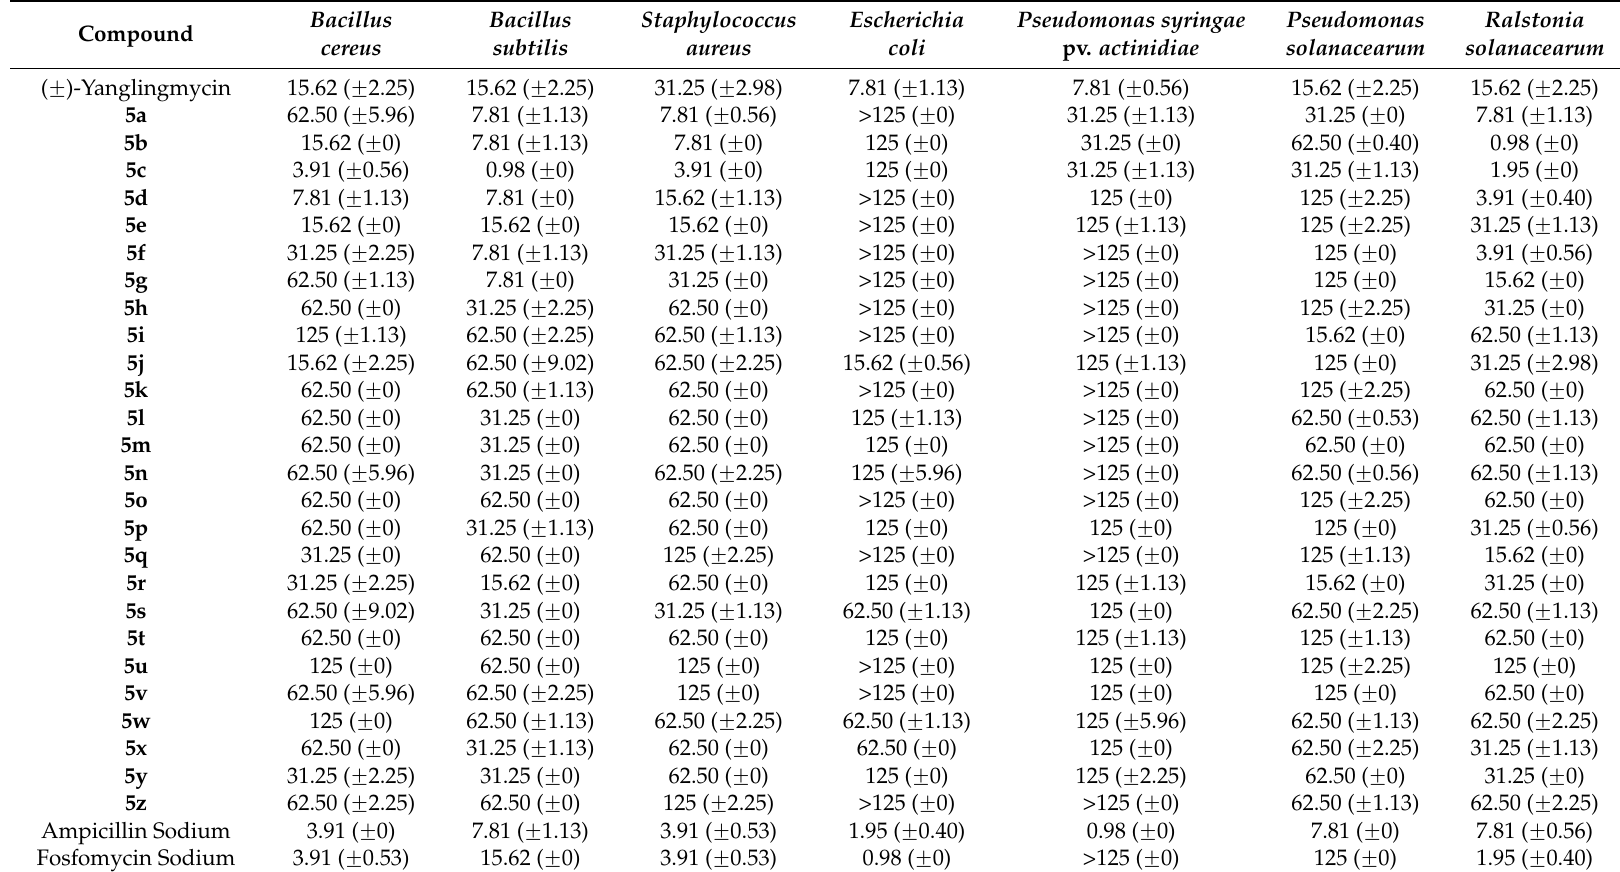
Table 1. The MICs of ( ˘ )-Yanglingmycin and its